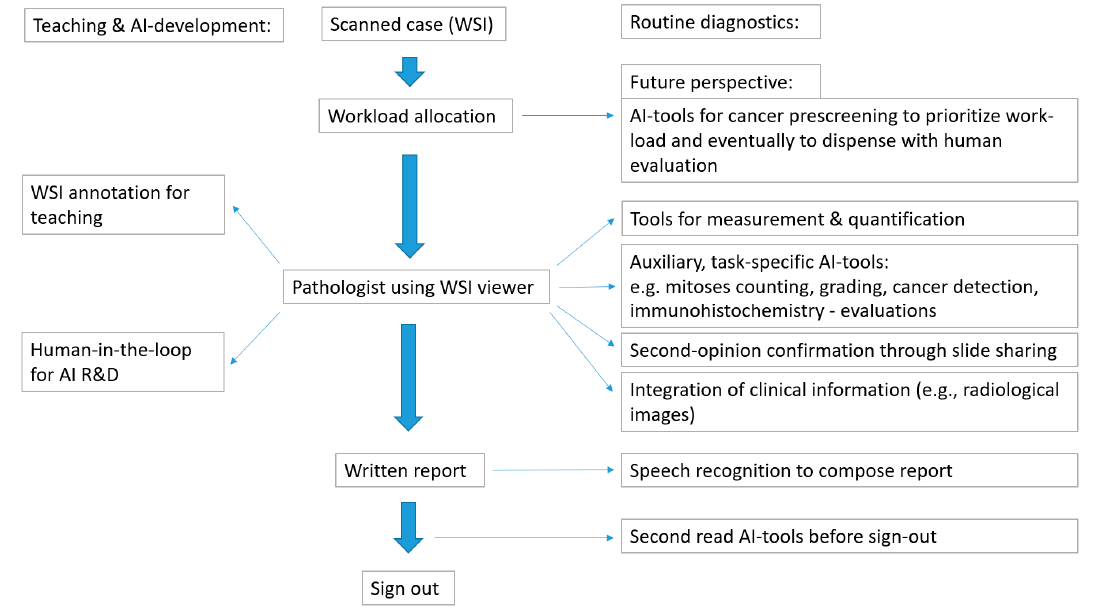
Figure 1. Outline for an integrated digital pathology (DP) work-flow.